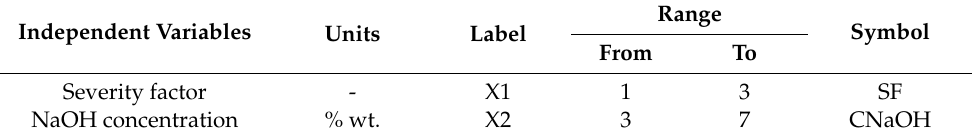
Range Symbol From To